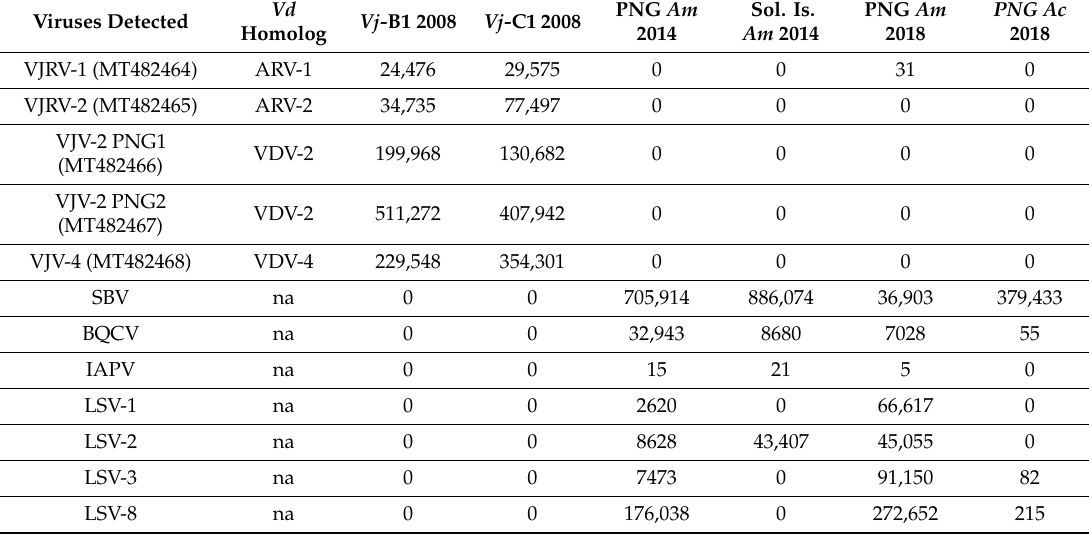
Table 1. Transcripts per million (TPM) for detected honey bee and Varroa